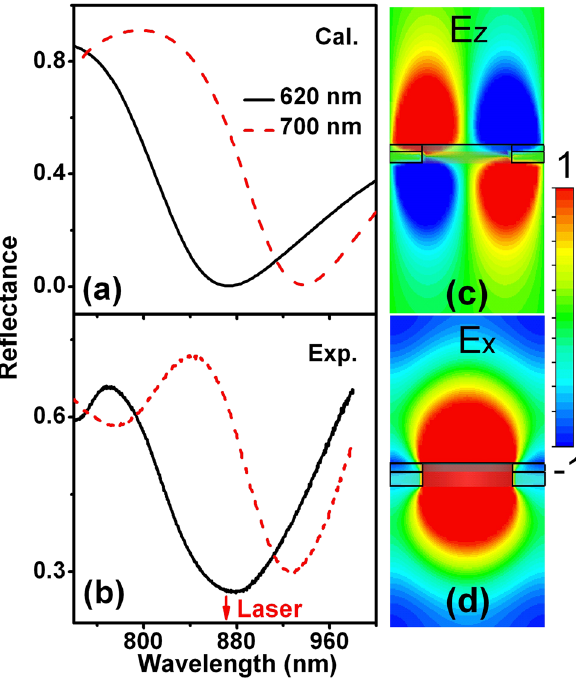
Figure 2: Calculated (a) and measured (b) reflection spectra with periods of 620 (black solid line) and 700 nm (red dash line), respectively. The red arrow refers to the excitation wavelength of pump laser. The electric fi eld E z (c) and E x (d) distributions at wavelength 869.6 nm for the perforated metallic structures with period of 620 nm.